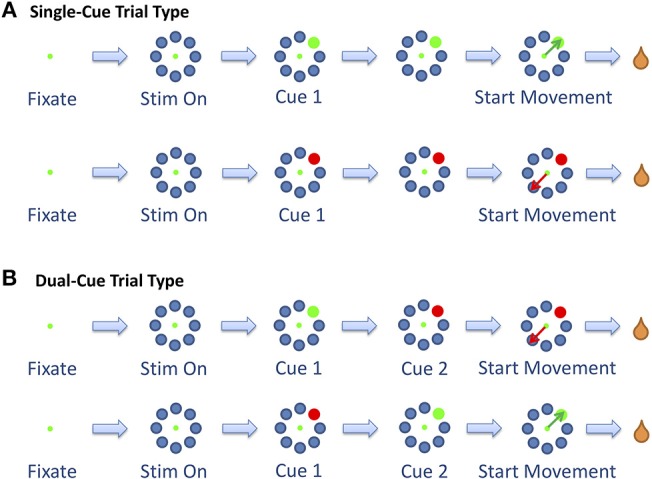
The two trial types. (A) The single-cue trial type consists of trials in which the stimulus did not change throughout the trial. (B) The dual-cue trial type consists of the trials in which the stimulus changed colors. Figure adapted from Saxena et al. (2011).